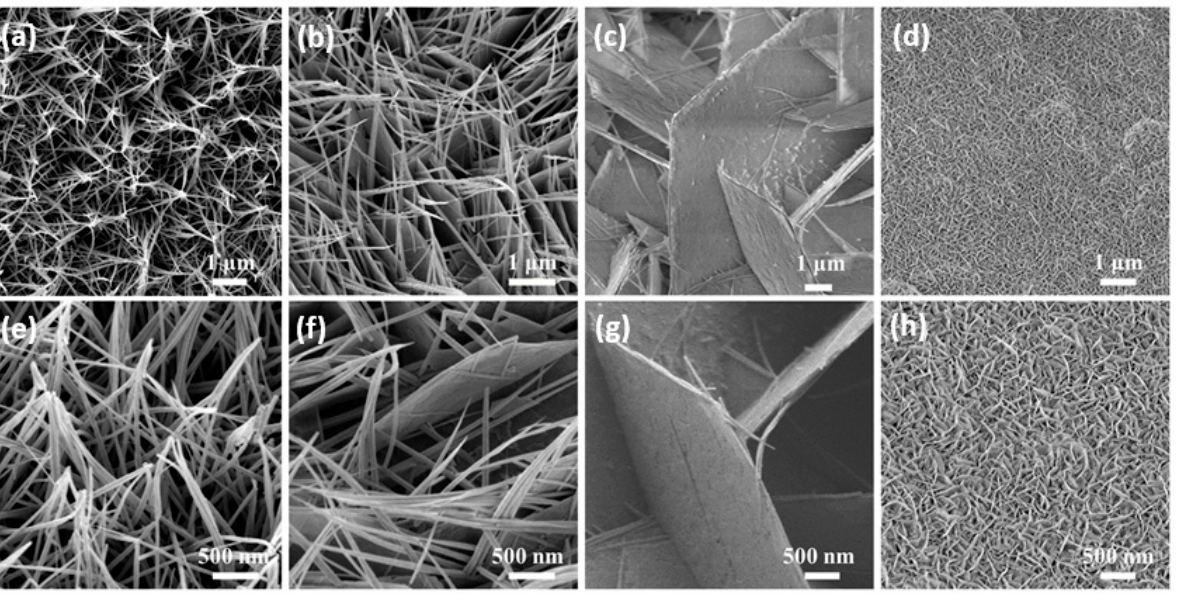
Figure 2. ( a – h ) Low and high magnification SEM images of the as-prepared samples ( a , e ) Co 3 O 4 ( b , f ) 0.1Mn-Co 3 O 4 ( c , g ) 0.3Mn-Co 3 O 4 ( d , h ) 0.5Mn-Co 3 O 4.